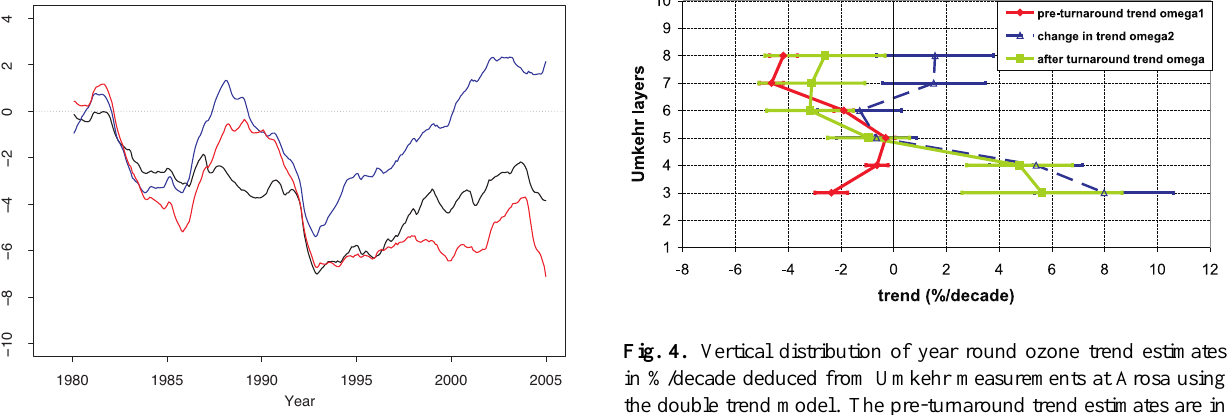
Fig. 3. Monthly mean column anomalies of SLIMCAT ozone (sim- ple gas-phase, blue; full chemistry, red) and merged TOMS and SBUV observations (black) between 35 ◦ –60 ◦ N. The anomalies have been smoothed with a 24-month running mean to average both over the annual cycle and the QBO (Updated from Hadjinicolaou et al., 2005).